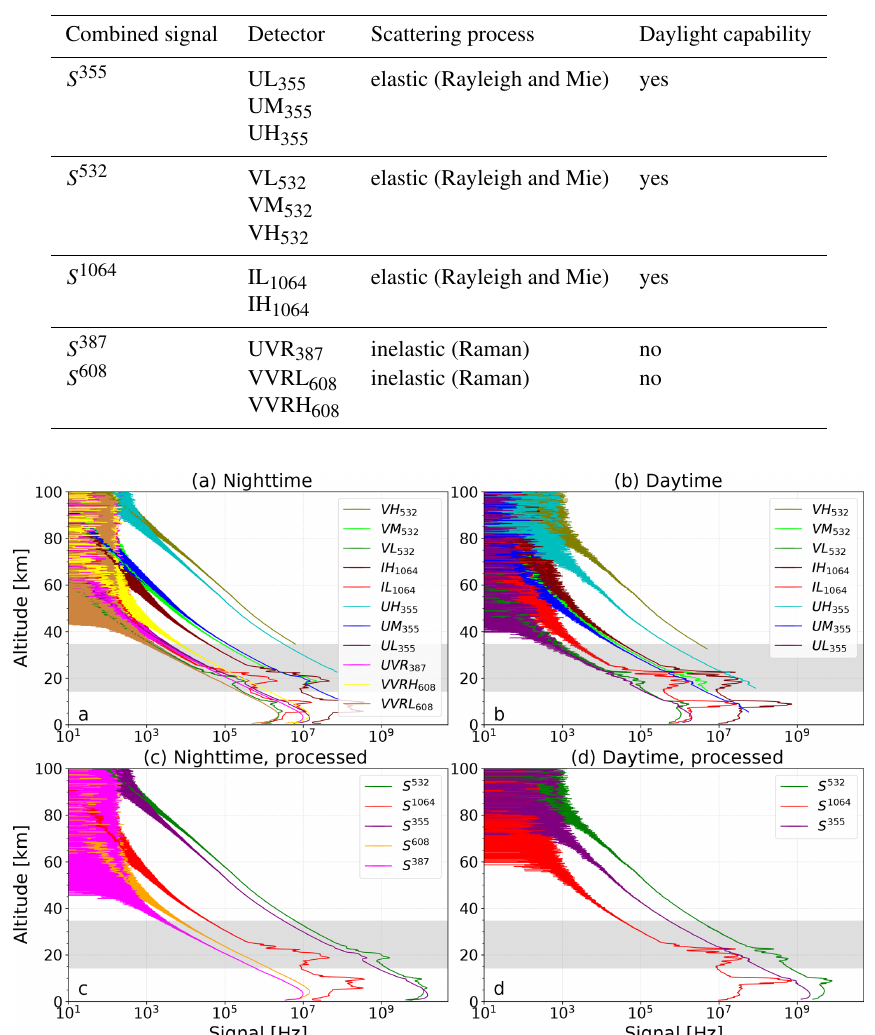
Table 1. Labels of combined signals and individual detectors. The name indicates in the first letter the spectral range (U – ultraviolet, V – visible, I – infrared), and the last letter indicates the sensitivity (L – low, M – middle, H-high). The letter pair “VR” indicates vibrational Raman scattered light. Indices represent the particular wavelength.